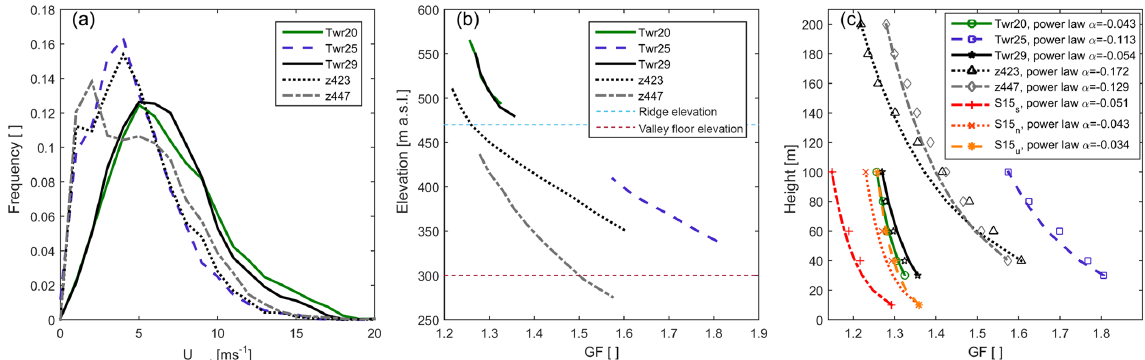
Figure 8. (a) Probability distributions of gust magnitude ( U gust ) at 100ma.g.l. as derived from sonic anemometers deployed on the three 100m towers and from the ZephIR lidars. (b) Median GF versus height above sea level (a.s.l.) for all 10min periods with U mean > 3ms − 1 from sonic anemometers and ZephIR lidars. The ridge and valley floor elevations above sea level are shown by the horizontal dashed lines. (c) Power-law fits to median GF as functions of height above ground level for 10min periods with U mean > 3ms − 1 . Also shown are results from measurements over flat terrain (Suomi et al., 2015), under stable (S15 s ), near-neutral (S15 n ), and unstable (S15 u ) conditions.